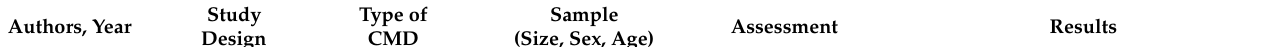
Table 3. Motor outcome measures in patients with LAMA2-RD (KAFO: Knee–Ankle–Foot Orthosis).